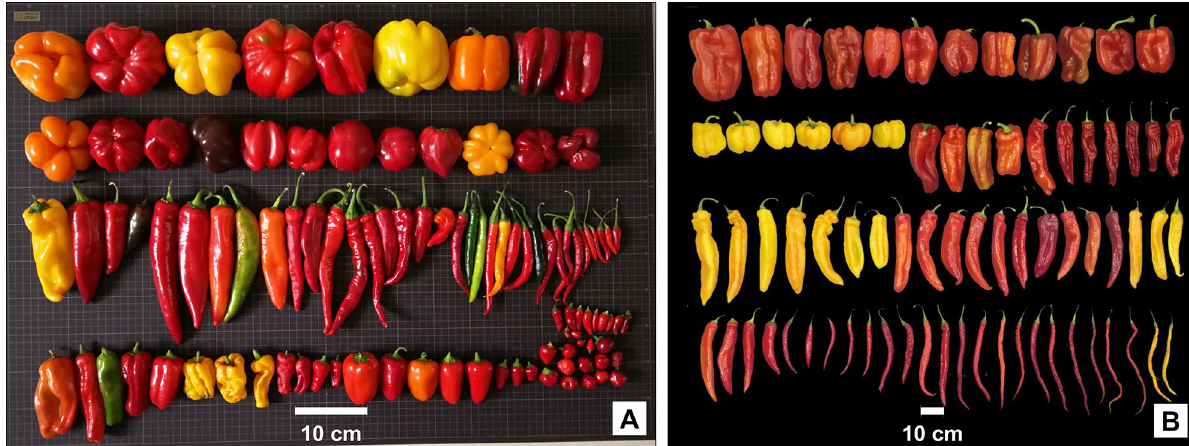
Figure 1. Examples of mature fruit types fruit harvested from the 94 local landraces ( A ) and from the 85 current breeding lines ( B were very large, while the plant height differences among current breeding lines were less, as was the average plant height (Table 3). Leaf morphology included three quantitative traits, including length of blade, width of blade and petiole length. Compared with landraces, the Shannon Diversity indices of the three traits of current breeding lines increased by 0.5, 0.34 and 0.43 respectively, and the coefficient of variation increased by 7.15%, 4.15% and 5.66% respectively. Comparing the mean values of the three traits in the two populations, it was found that the average length and width of blade in the current breeding lines increased by 3.91 cm and 1.88 cm, respectively, and the average petiole length increased by 2.25 cm (Table 3). Data of first flower and the first flowering node are maturity-related traits. The Shannon Diversity indices of the two traits in landraces were 1.93 and 2.06, respectively, while those in current breeding lines were 1.70 and 1.75, a reduction of 0.23 and 0.31, respectively. Comparing the maximum, minimum, range and average values of the two traits in the two populations, it was found that the longest flowering period in the two populations were both 124.4 days and the shortest were 73.6 days and 54.1 days, respectively. The average time of beginning of flowering of the current breeding lines was 8.2 days less than that of the local landraces. The first flowering node of local landraces ranged from 5.2 to 23.8 with a mean value of 10.2, while the range of first flowering node of current breeding lines ranged from 4.5 to 16.3 with a mean value of 9.7 (Table 3). The above results showed that the flowering characteristics related to maturity varied greatly among landrace lines, while these characteristics for current breeding lines were earlier than those of the local landraces. Seven quantitative traits related to fruit included fruit pedicel length, single fruit weight, fruit longitudinal diameter, fruit transverse diameter, thickness of flesh, number of locules and the fruit firmness (Table 3). Com- pared with local landraces, the Shannon Diversity indices of current breeding lines for single fruit weight, fruit longitudinal diameter, fruit transverse diameter and thickness of flesh increased by 0.88, 0.38, 0.14 and 0.36, respectively. The single fruit weight of local landraces ranged from 1.1 to 202.1 g, with a mean value of 37.8 g. The single fruit weight of current breeding lines ranged from 6.4 to 409.8 g, with an average value of 121.7 g. The mean value of single fruit weight of current breeding lines was 3.2 times higher than that of landraces. Fruit longitudinal diameter, transverse diameter and thickness of flesh were closely related to single fruit weight. The average values of the above three traits in current breeding lines increased by 8.9 cm, 1.4 cm and 0.13 cm, respec- tively. The Shannon Diversity indices of fruit pedicel length and number of locules in current breeding lines was less 0.13 and 0.17, respectively, compared to that of landraces. The fruit pedicel lengths of local landraces and current breeding lines ranged from 2.4 to 7.3 cm and 2.6 to 9.0 cm, respectively, with an average value of 4.1 cm and 5.0 cm, respectively. The average fruit pedicel length of current breeding lines was 0.9 cm longer than that of landraces. There was no difference in the range of the number of locules between landraces and current breeding lines, but the mean number of locules in landraces and current breeding lines were 2.8 and 3.2, respectively. This result may be related to the 9.6% increase in the proportion of lantern-shaped pepper in current breeding lines. Compared with landraces, the mean of fruit firmness was less 3.95 Pa in current breeding lines, which may be due to the higher proportion of lines with large fruit in current breeding lines (Table 3). Genetic diversity based on SSR and InDel markers. The genotyping of 94 landraces and 85 current breeding lines revealed 26 SSR and 1 InDel marker loci diversity (Tables 4, 5). A total of 251 alleles were amplified from 27 markers in the landraces. The number of alleles at different loci ranged from 2 to 20, and the average number of alleles per locus was 9.3. Gene Diversity index (GDI) and Poly- morphism Information content (PIC) ranged from 0.16 to 0.88 and 0.14 to 0.87, with an average value of 0.56 and 0.53, respectively. Among these markers, the GDI and PIC of marker Epms331 were the highest, which were 0.88 and 0.87, respectively. The GDI and PIC of marker Epms391 was the lowest, which were 0.16 and 0.14, respec- tively (Table 4 and Supplementary Fig. 1). Observed heterozygosity was highly variable between loci (0.01–0.94), with an average value of 0.16, indicating that the local landraces were not fixed to homozygosity (Table 4).